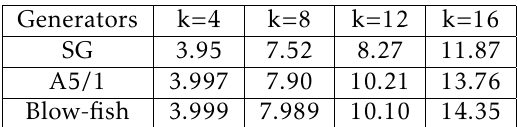
Table 1. Entropy values for reference cryptosystems for k = 4 , 8 , 12 , 16